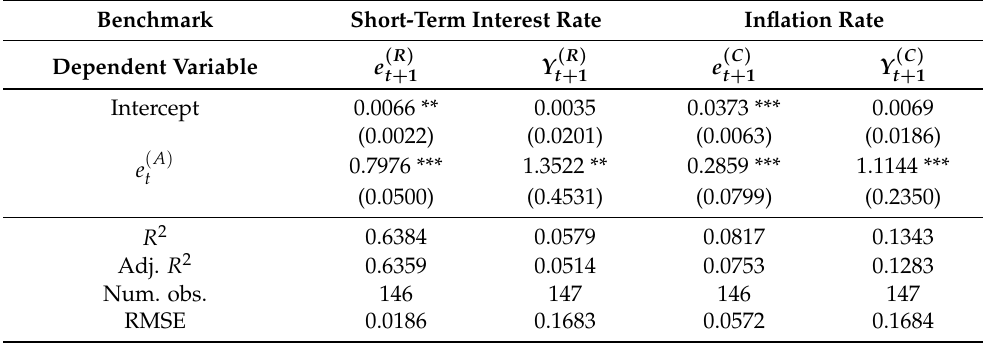
Table 6. Estimated parameters (and standard errors in parentheses) of the linear Models (11) and (12) used for the econometric model in Section 2.4 under the short-term interest rate benchmark or the inflation benchmark. R 2 , the standard coefficient of determination of a linear model; Adj. R 2 , the adjusted R 2 ; Num. obs., the number of observations used in the regression; RMSE, root mean square